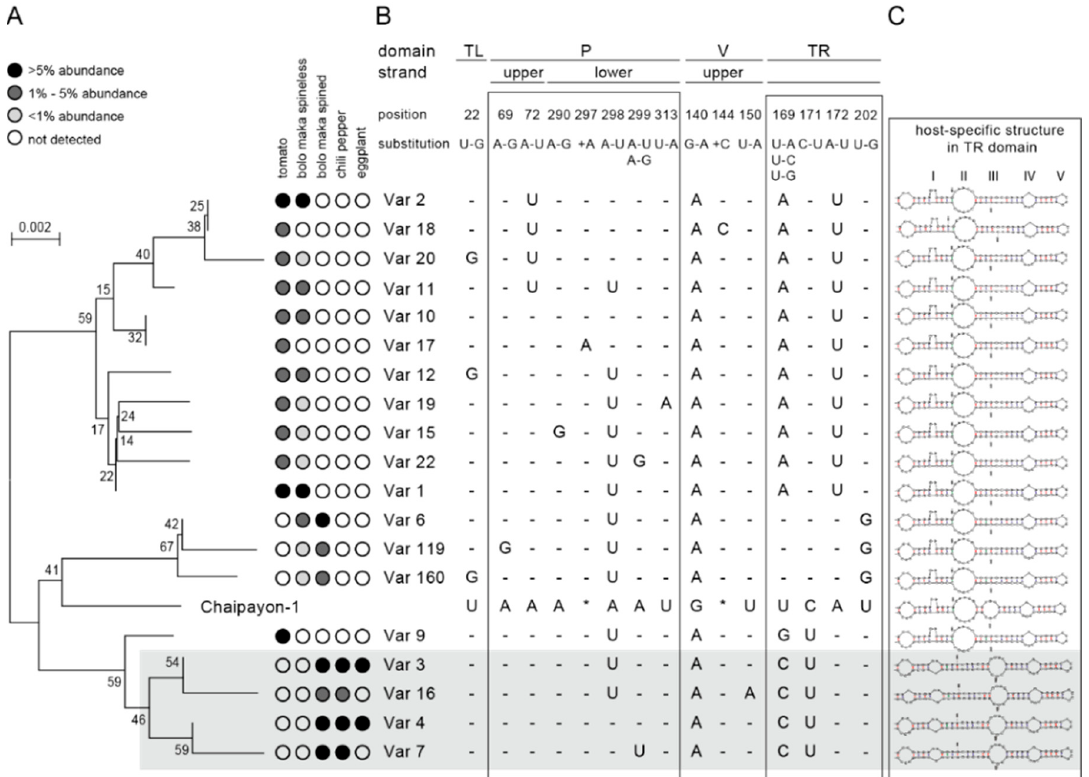
Figure 2. Host specific CLVd major variant analysis. ( A ) Phylogenetic tree showing the sequence similarity between major variants (>1% average relative frequency in at least one plant). Bootstrap values are indicated at the nodes. Colored circles next to the phylogenetic tree indicate abundance across plant species (black >5%; dark grey, 1–5%; light grey, 0–1%; white, 0%). ( B ) Chaipayon-1 sequence and major variant sequences at specific positions where they differ from each other. “position” indicates the position in the Chaipayon-1 reference sequence. “substitution” shows the mutation that occurred. - indicates that the sequence was the same as the Chaipayon-1 sequence. * indicates insertions. ( C ) Predicted secondary structure of each major variant. Variant3, Variant16, Variant4 and Variant7 are shaded gray because their loops are positioned at other locations compared to the other major variants.